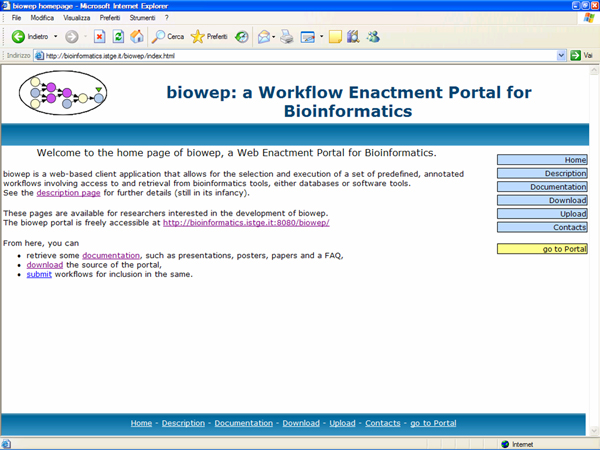
Home page of biowep support site. In this figure, the home page of the support web site is shown. Interested researchers can retrieve from the site all available documentation. They can also download software, database structure, workflows and submit their workflows. The same account can be used for the support site and the portal.